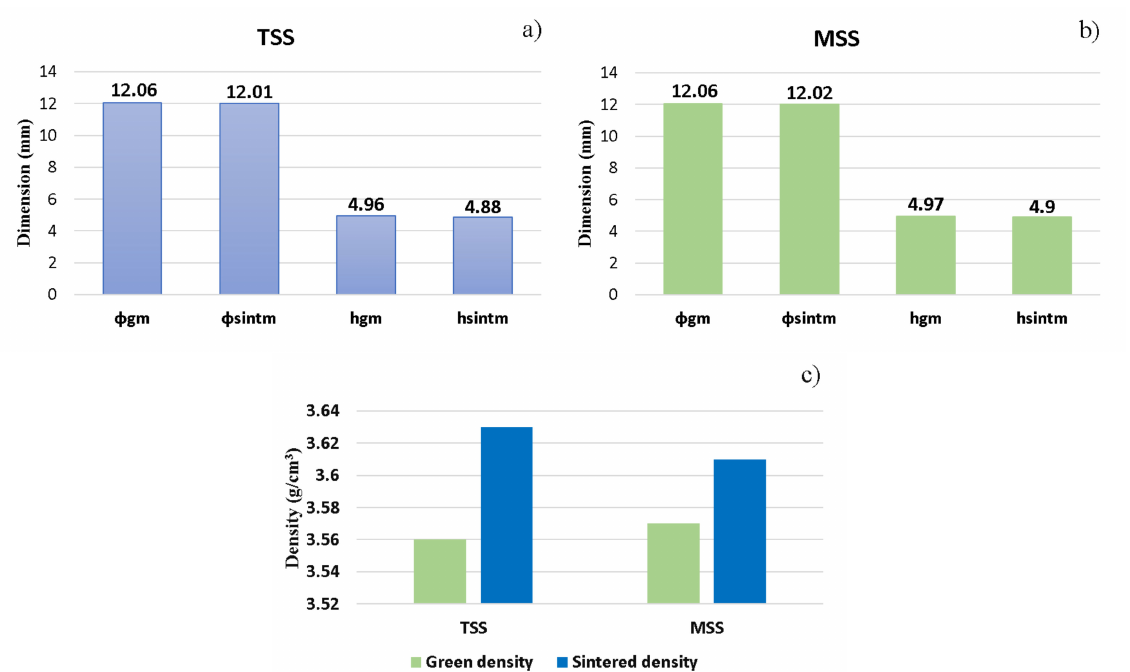
Figure 7. The final physical properties: ( a ) the average dimensions for green and sintering samples, obtained by two-step sintering (TSS); ( b ) the average dimensions for green and sintering samples, obtained by multiple-step sintering MSS; ( c ) green and final density versus sintering cycle ( φ gm—the diameter measured after compaction, φ sintm—the diameter measured after sintering, hgm—the height of the parts after pressing and hsintm—the height of the parts measured after sintering).